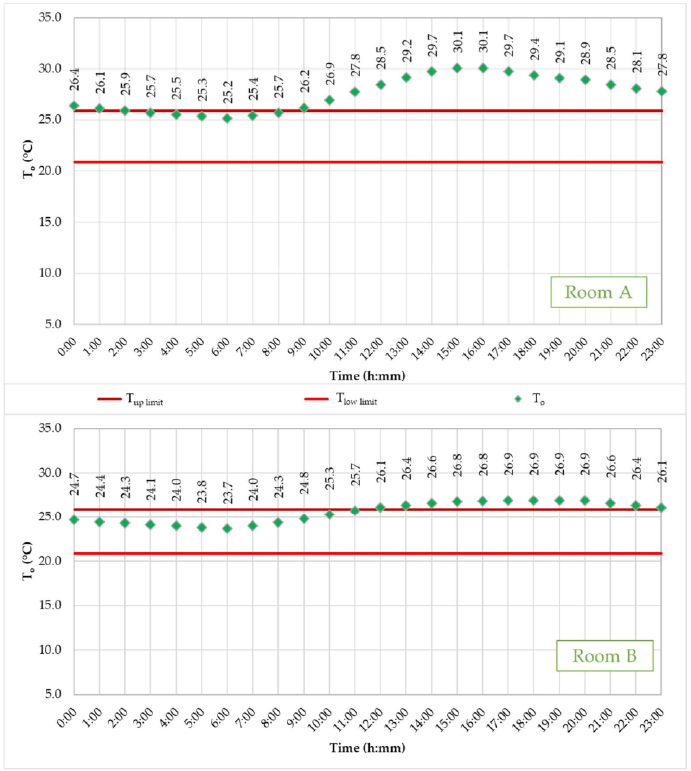
Figure 17. Hourly operative temperature for the autumn day.